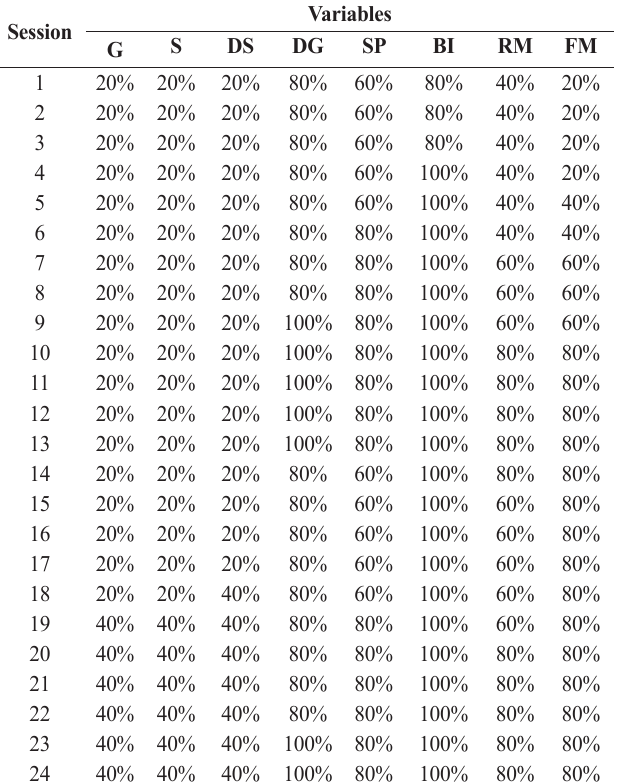
Table 2. Score achieved by participating in eight skills evalu- ated by IAADE during each session.